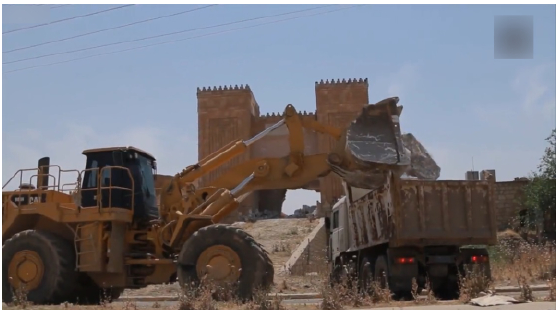
Figure 23. Image released by ISIL of heavy equipment vehicles at Nergal Gate in May 2016 [76].